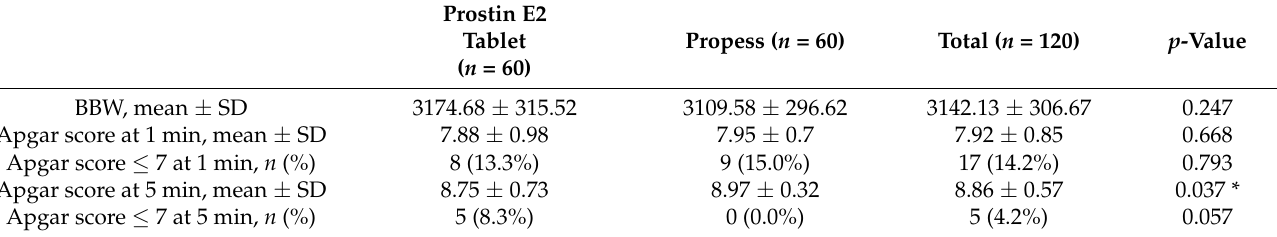
Table 3. Neonatal outcomes.